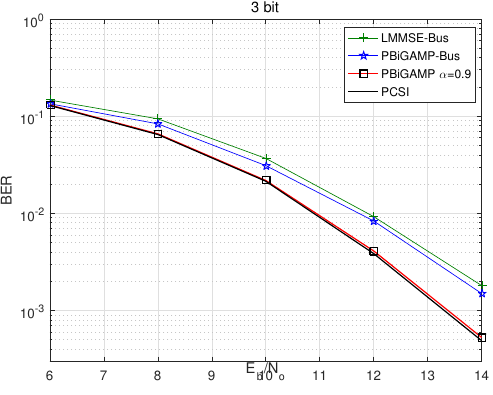
Figure 6. BER performance versus E b / N o at 10-th Turbo iteration for investigated